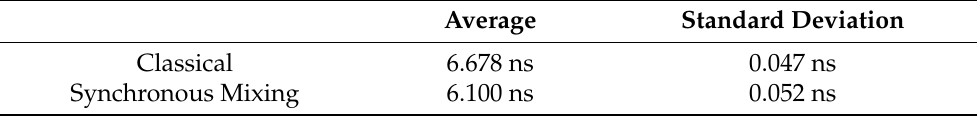
Figure 17. Amplitude and step response of the classical and synchronous mixing architectures: ( a ) amplitude response; ( b ) step response. Table 3. The rise time (10–90% ) of the two architectures.